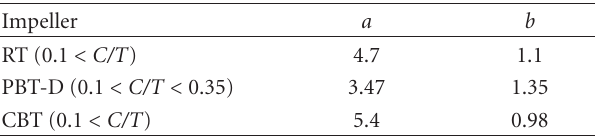
Figure 7: Comparing measured values for just-suspended speed by densitometry technique and predicted ones with di ff erent models [3, 37, 49]. Table 4: Values for a and b parameters in equation 3 for di ff erent